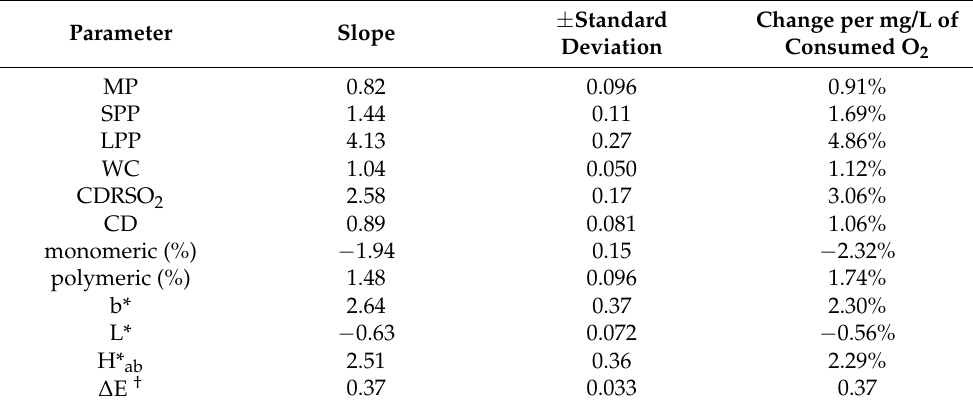
Table 4. Average rates of change of pigments and color during five-phase oxidation.